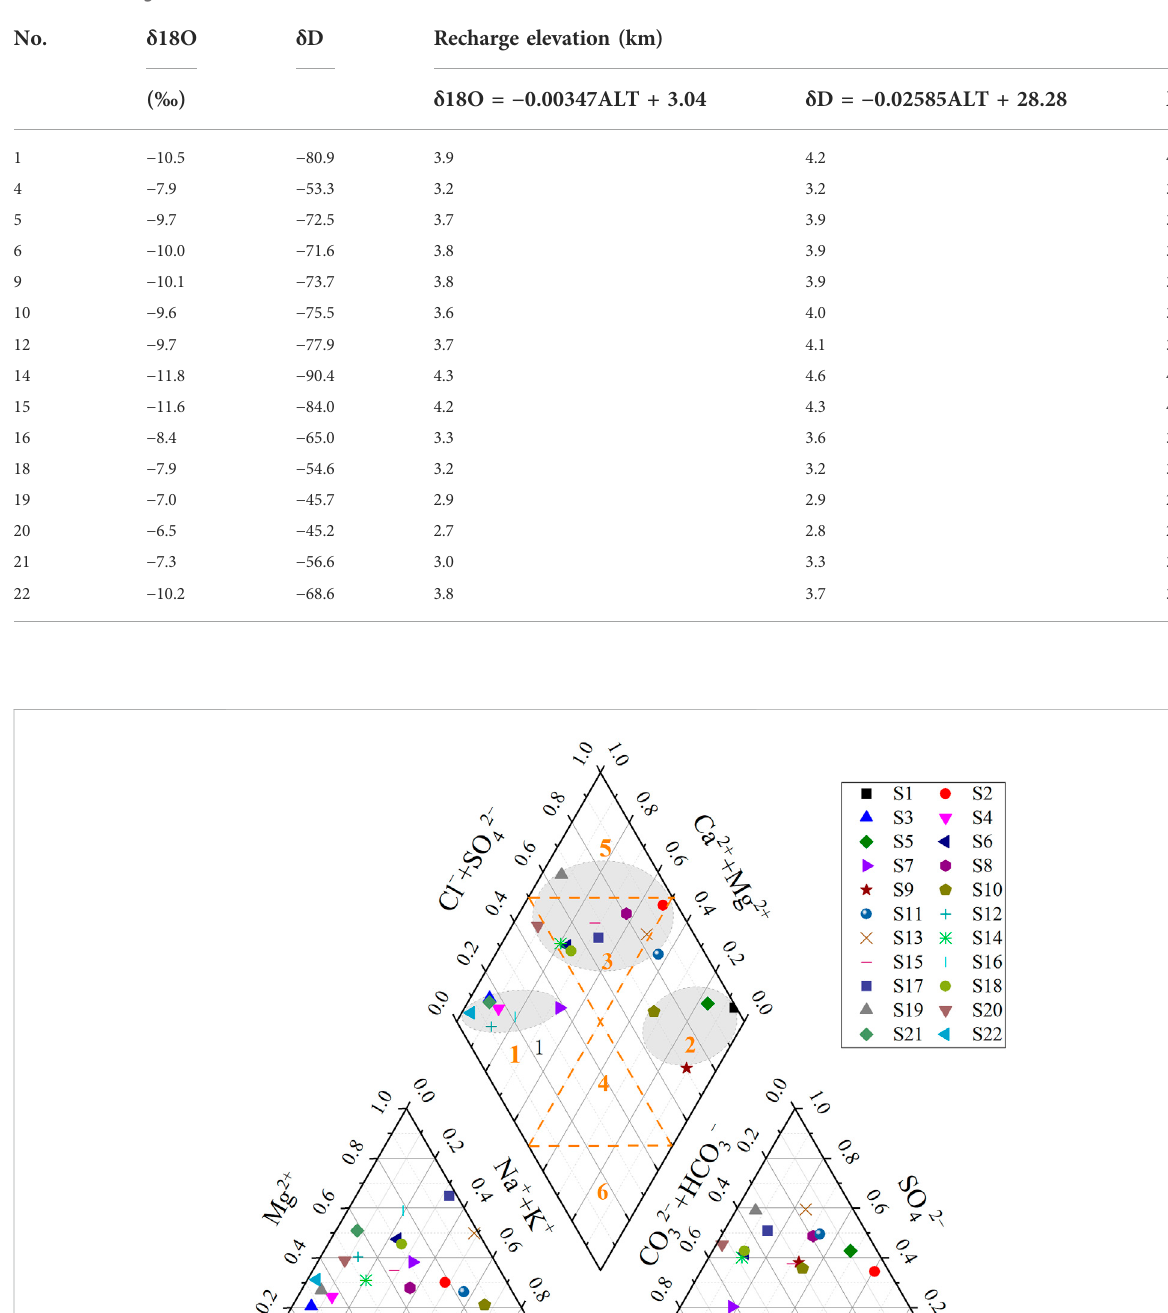
TABLE 1 Recharge elevation in the QHF.